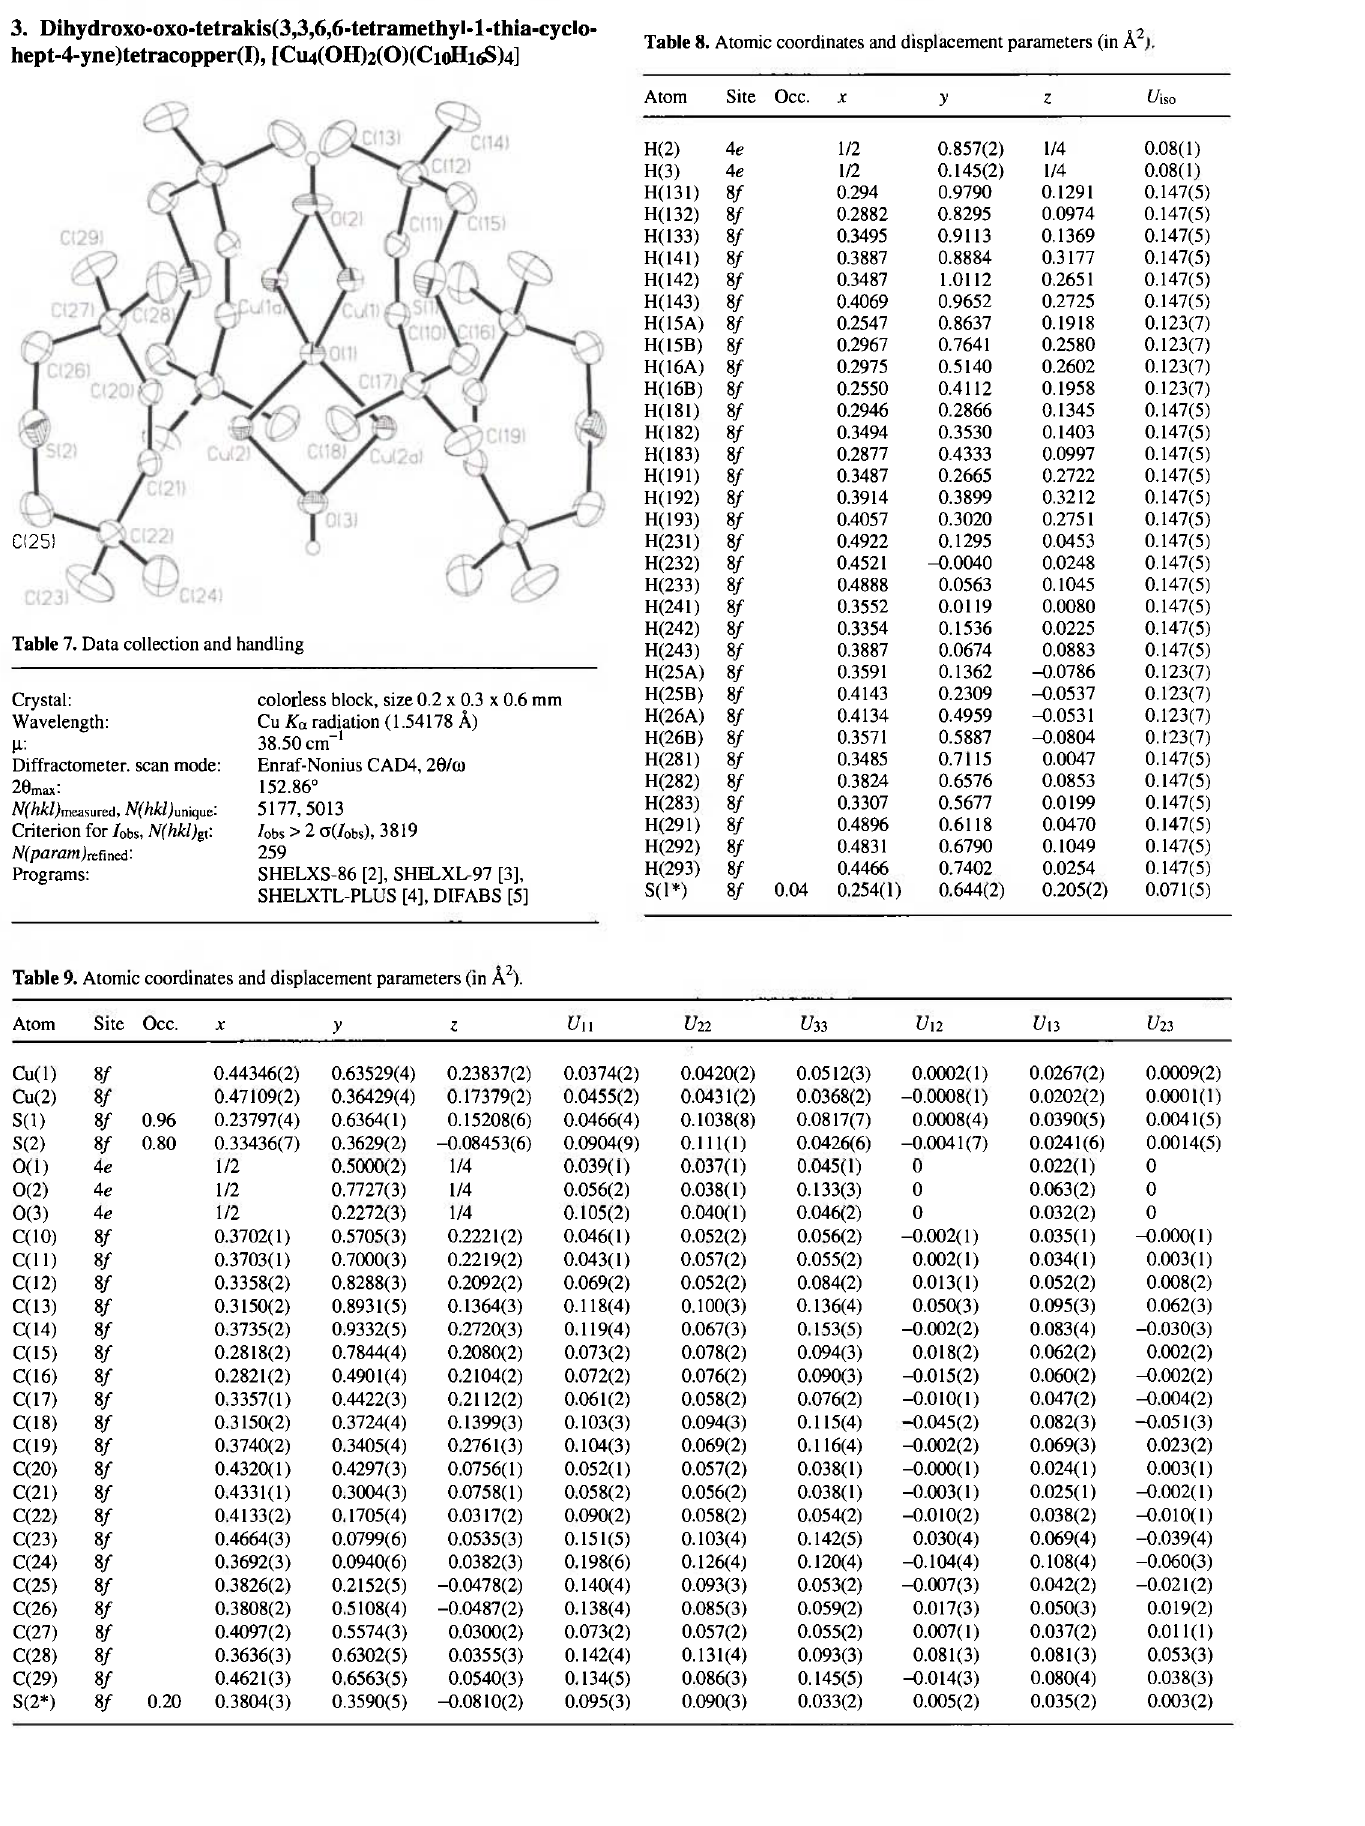
Table 8. Atomic coordinates and displacement parameters (in A 2